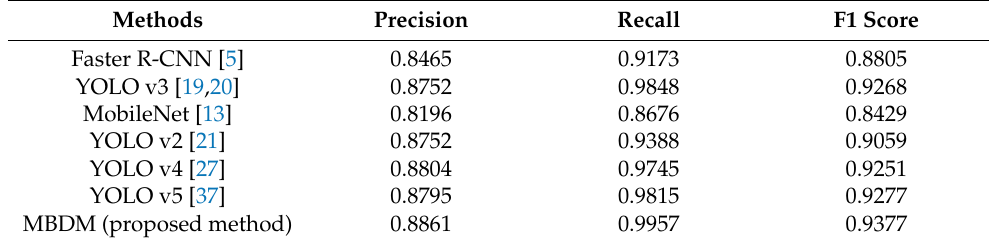
Table 9. Performance comparisons of the proposed method and the state-of-the-art methods with USD.